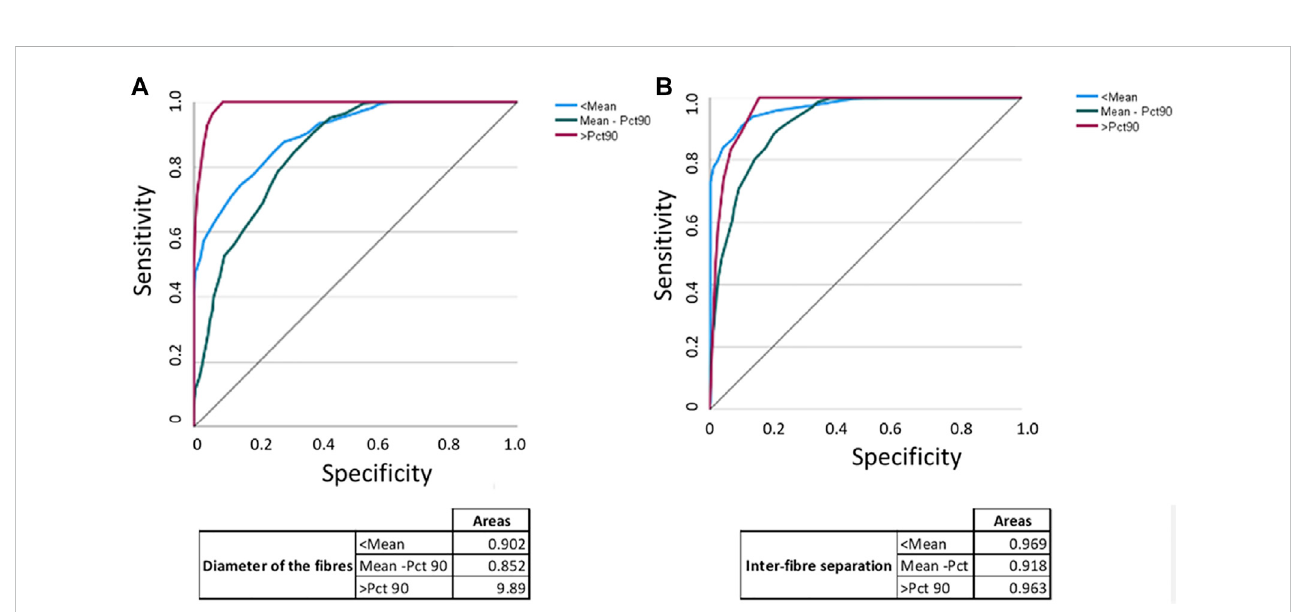
FIGURE 5 Sensitivity vs. speci fi city and areas under the curve for (A) diameter of the fi bres and (B) inter- fi bre